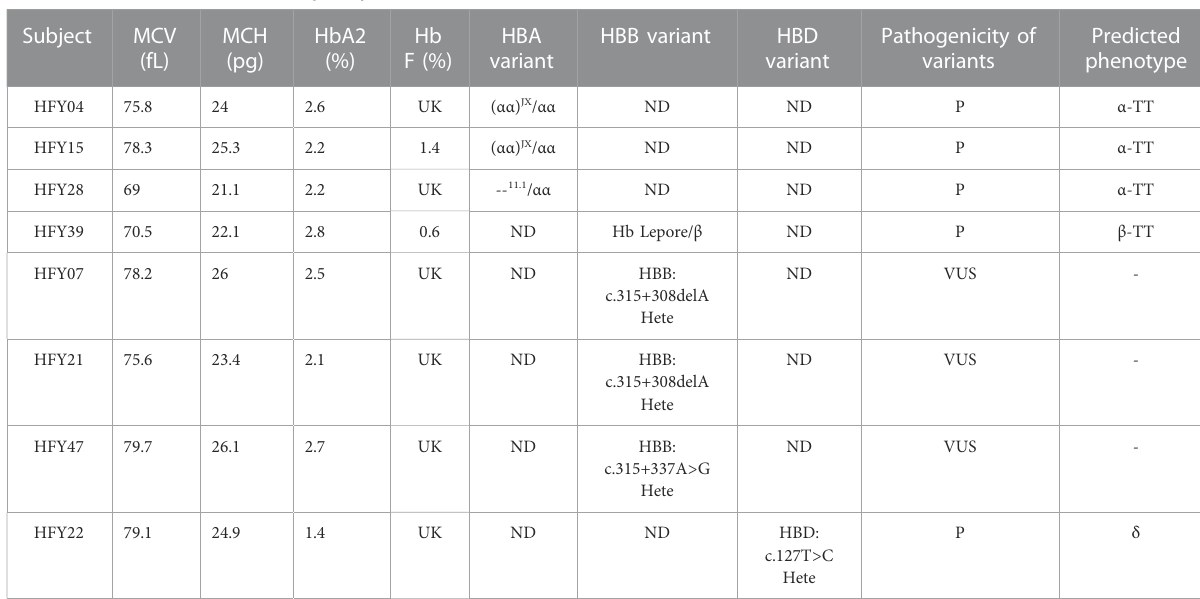
TABLE 1 Variants identi fi ed in the samples by